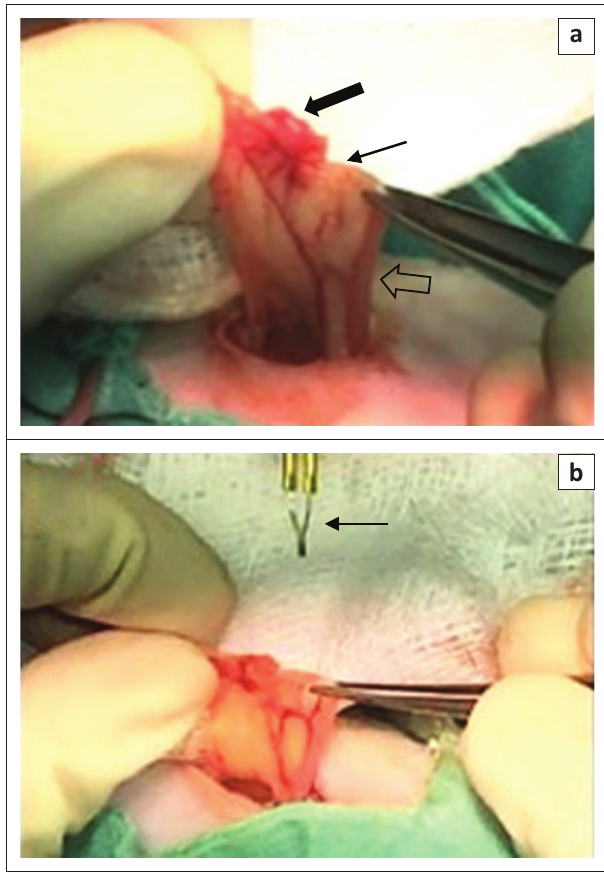
FIGURE 1: The incised ovarian bursa and isolated salpinx. (a) Isolation of the salpinx after careful incision of the ovarian bursa. Solid thick black arrow indicates ovary, thin black line arrow indicates salpinx and black arrow outline indicates uterine horn. (b) The distal portion of the isolated salpinx was resected using fine-tipped electrocautery indicated by thin black